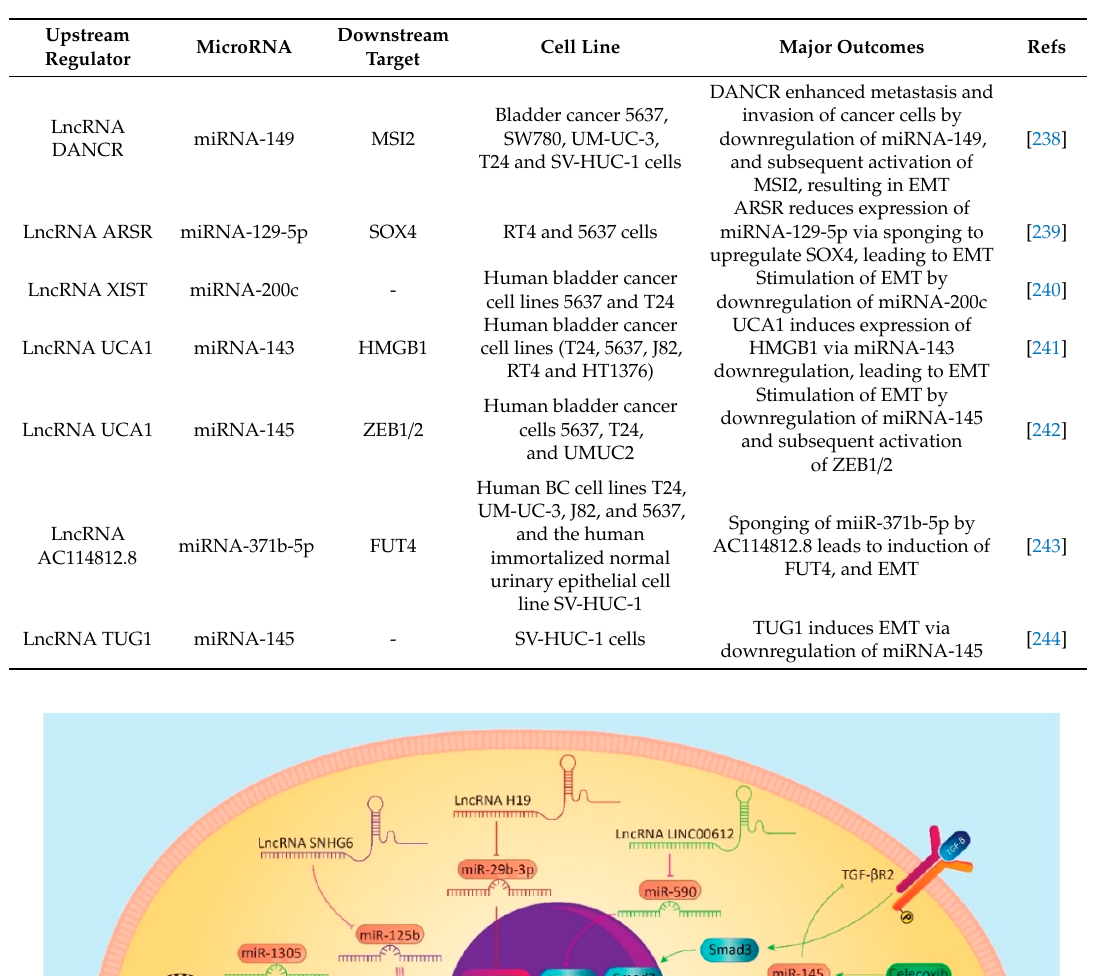
Table 2. Regulation of microRNA / EMT axis in BC cells.